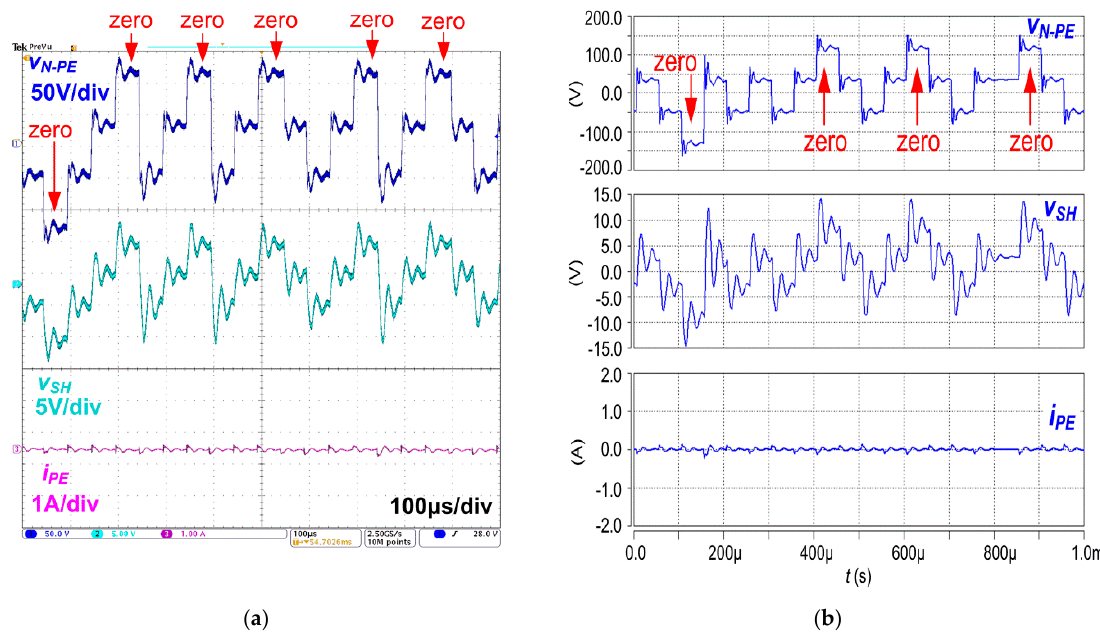
Figure 19. Waveforms of CM voltage u N-PE , shaft voltage u SH, and leakage ground current i PE in a drive system fed by a hard-switched inverter with 720 µH common-mode choke: ( a ) measurement; ( b ) simulation.